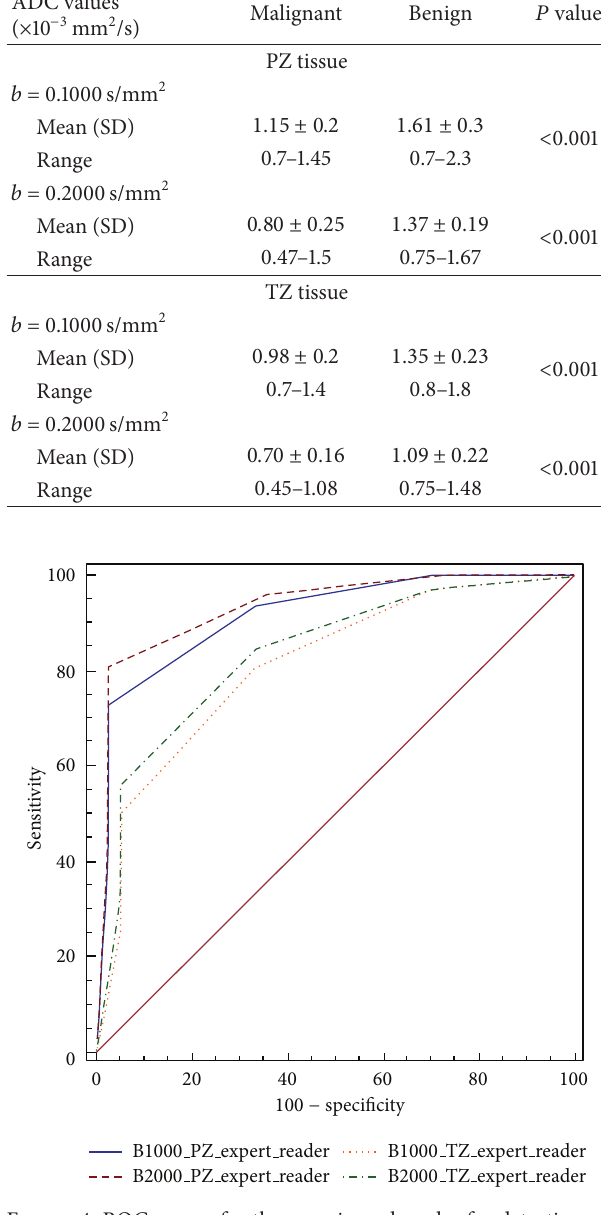
Figure 4: ROC curves for the experienced reader for detection of prostate cancer in the PZ (blue and red lines) and TZ (yellow and green lines) using native DWI images at 𝑏 -values of 1000s/mm 2 and 2000 s/mm 2